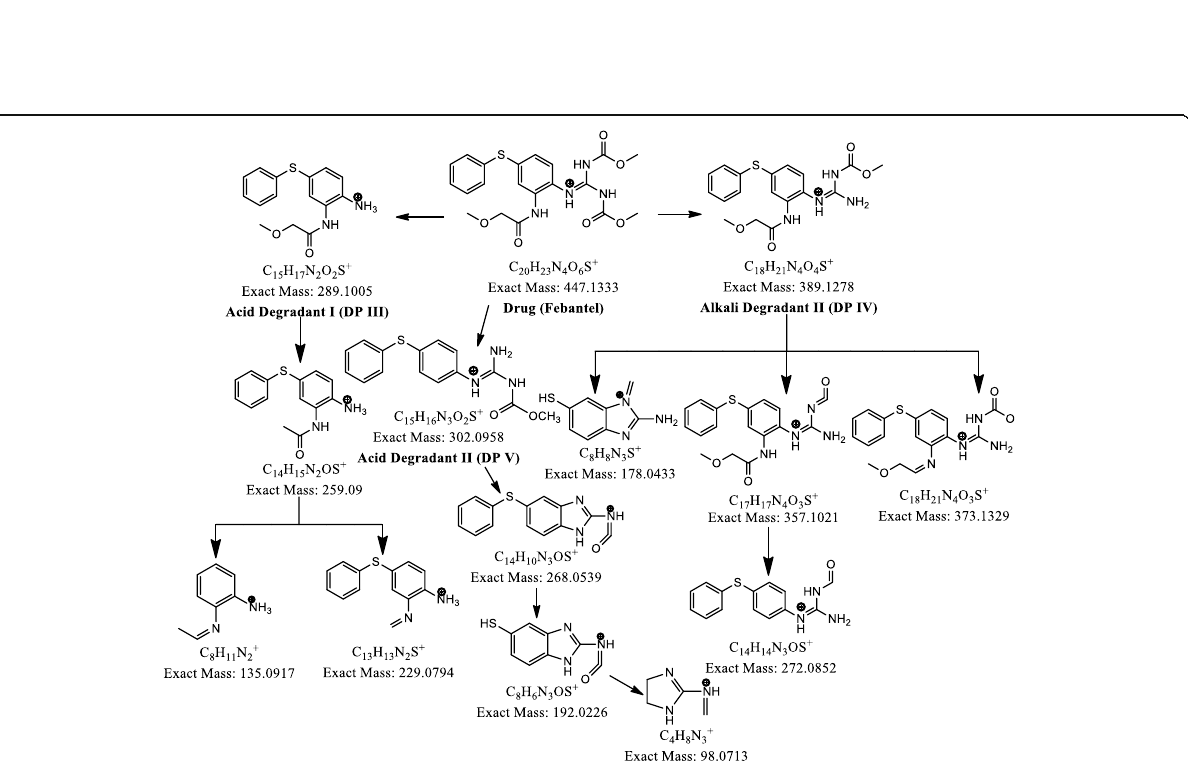
Scheme 2 Proposed mass fragmentation pathways of three degration products of